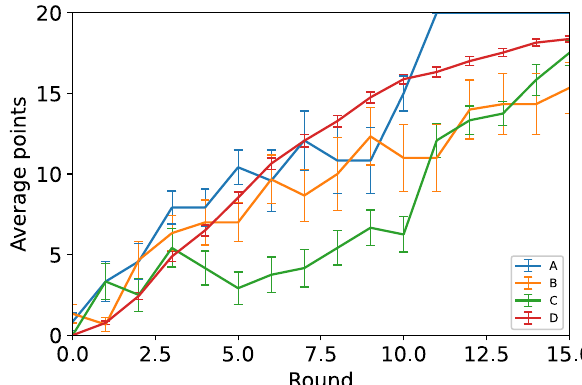
Figure 2. Average number of points in each round for the different setups. Games with setup A reached the maximum number of points in all of the 4 games while the hybrid setups B and C as well as the setup D did not reach that within the maximum of 15 rounds The scheme of receiving the maximum reward for each 3-game series resulted in the players playing four games of setup A, five games of setup B and four games of setup C. The setup D consists of 100 realizations of the game simulated with cooperative autonomous agents. Out of the four setups, the hybrid setup B resulted in the worst performance. However, the difference between the hybrid setups is minor as individual players in one of the colour groups in setup B achieved the maximum reward before the fifth game (i.e. achieved a total sum of 27 points). The error bars represent the standard errors.